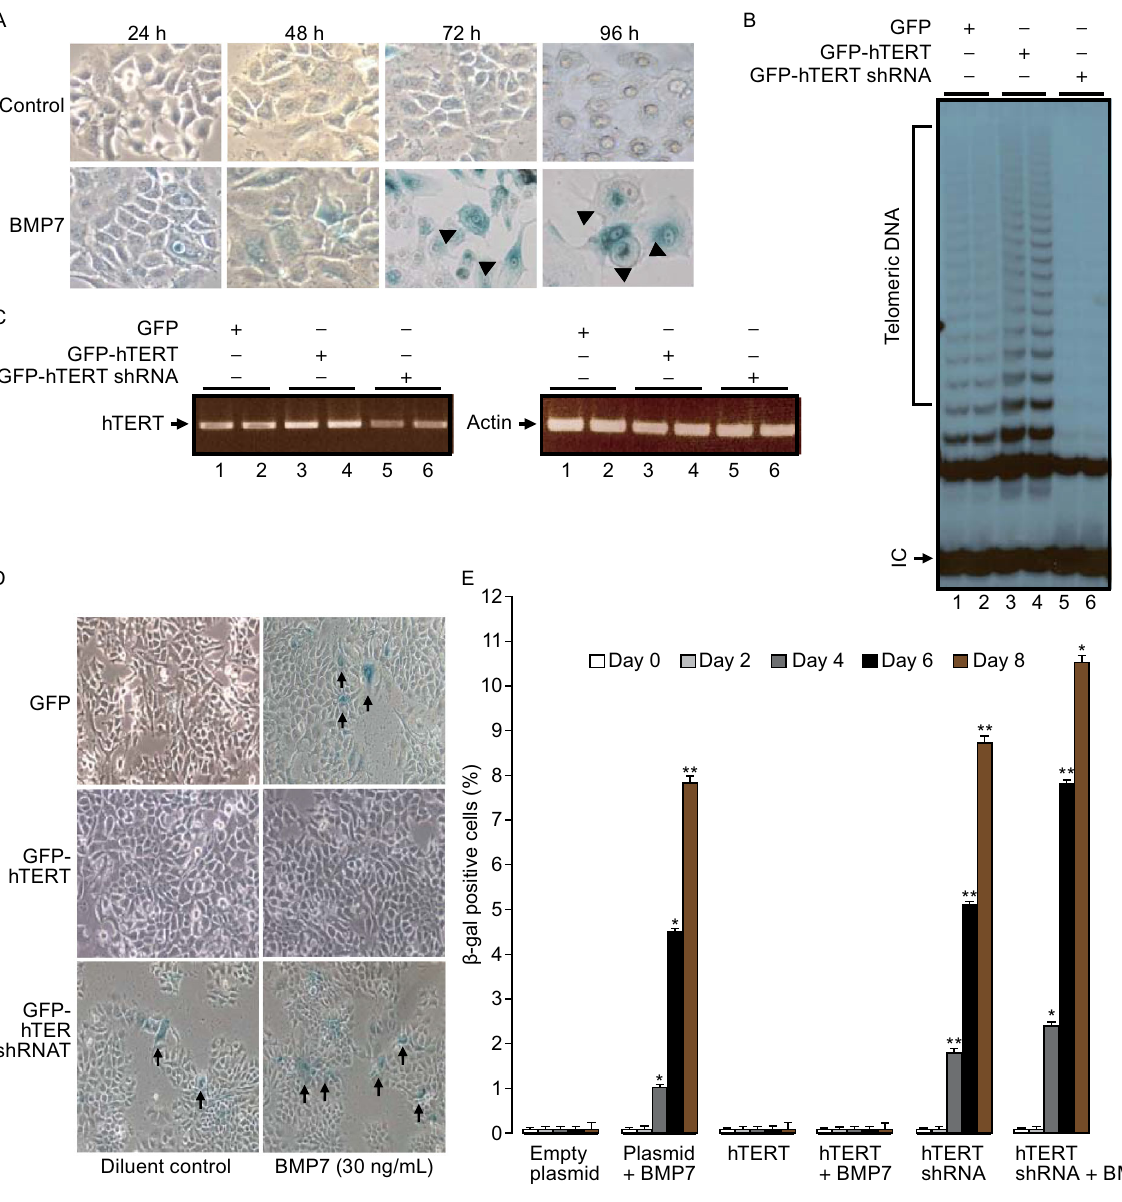
Figure 3. BMP7-induced breast cancer cell senescence is dependent on hTERT gene repression. (A) β -galactosidase activity determined by β -Gal staining in cultured MCF-7 cells treated with BMP7 (10 ng/mL) for different periods of time. Results were from phase contrast microscopy at 20X magni fi cation. Arrowed are enlarged β -galactosidase positive senescent cells. (B) Up- and down- regulation of telomerase activity by GFP-hTERT and GFP-hTERT shRNA. MCF-7 cells were transfected for 24 h. Total cell